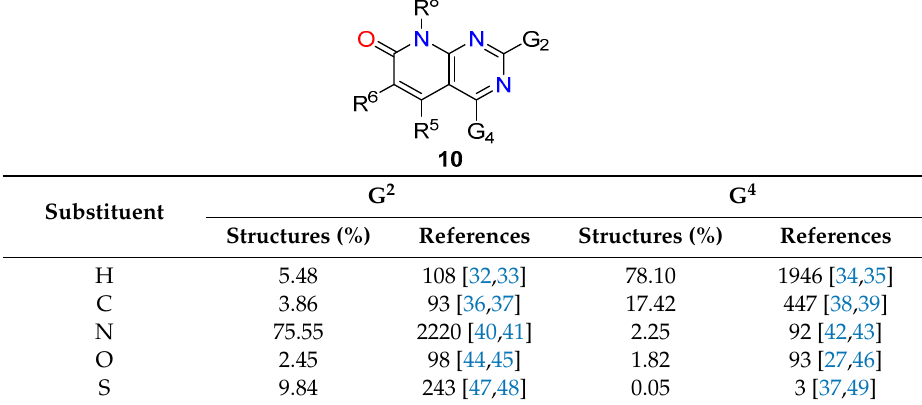
Table 2. Substitution pattern at C2 and C4 of pyrido[2,3- d ]pyrimidin-7(8 H )-ones ( 10 ) with a C5-C6 double bond.